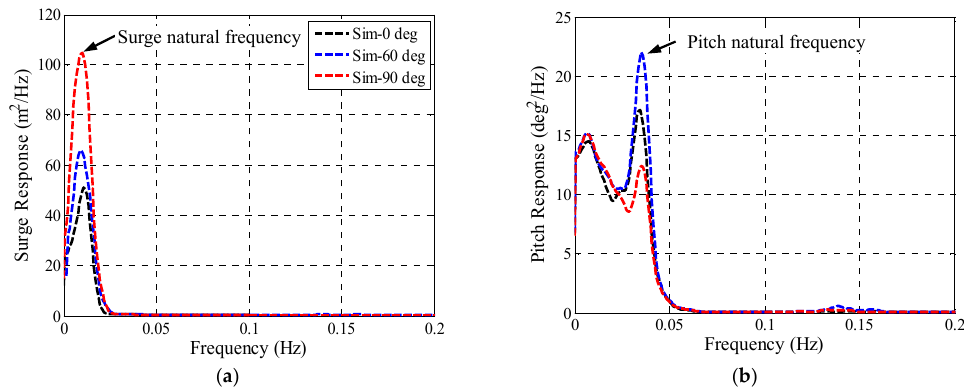
Figure 26. PSD plot of ( a ) surge motion and ( b ) pitch motion.